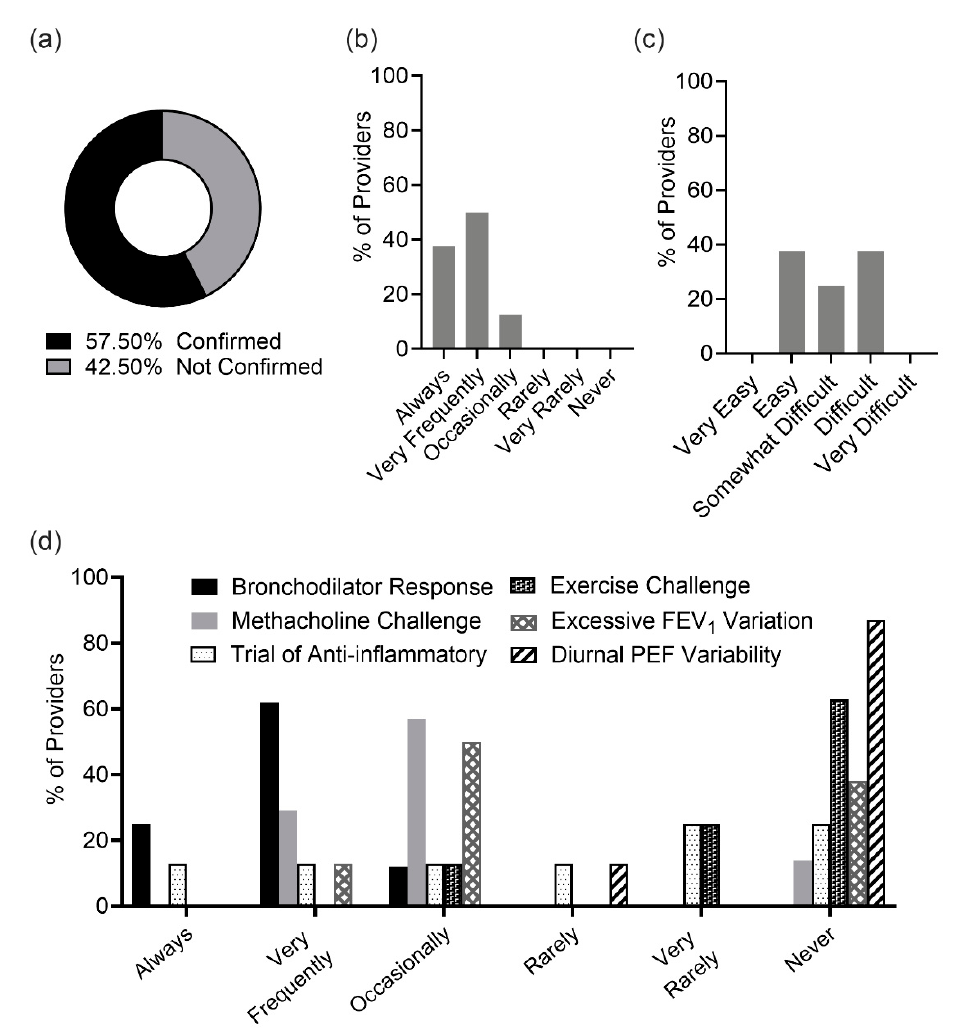
Figure 1. Asthma Confirmation: ( a ) The proportion of patients with an appropriate confirmatory test prior to initiation of biologic therapy, ( b ) shows survey results on how often providers seek to confirm asthma diagnosis prior to starting biologic modifiers, ( c ) shows survey results on provider perception on the di ffi culty of confirming asthma diagnosis, ( d ) shows providers’ response to a survey question on how often they use the various methods to confirm asthma diagnosis in their patients before starting biologic